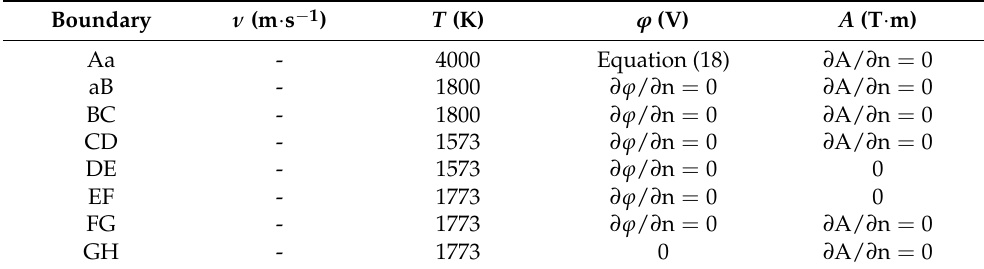
Table 1. External boundary conditions of the